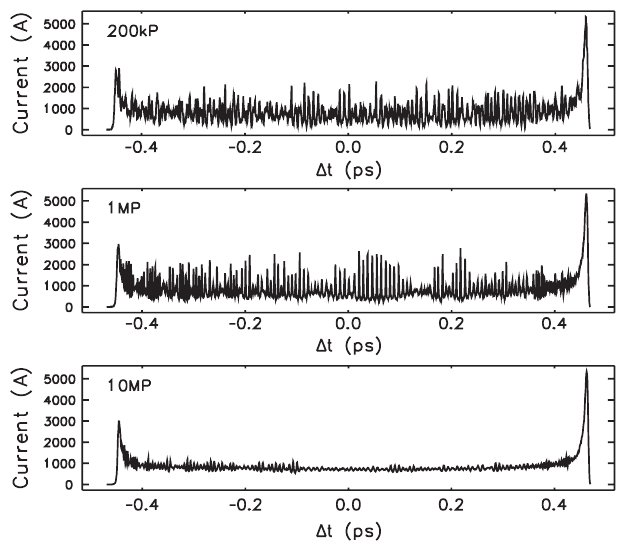
FIG. 5. Final longitudinal density for FERMI, showing the result of increasing the number of particles from 200 000 to 10 (cid:1) 10 6 .